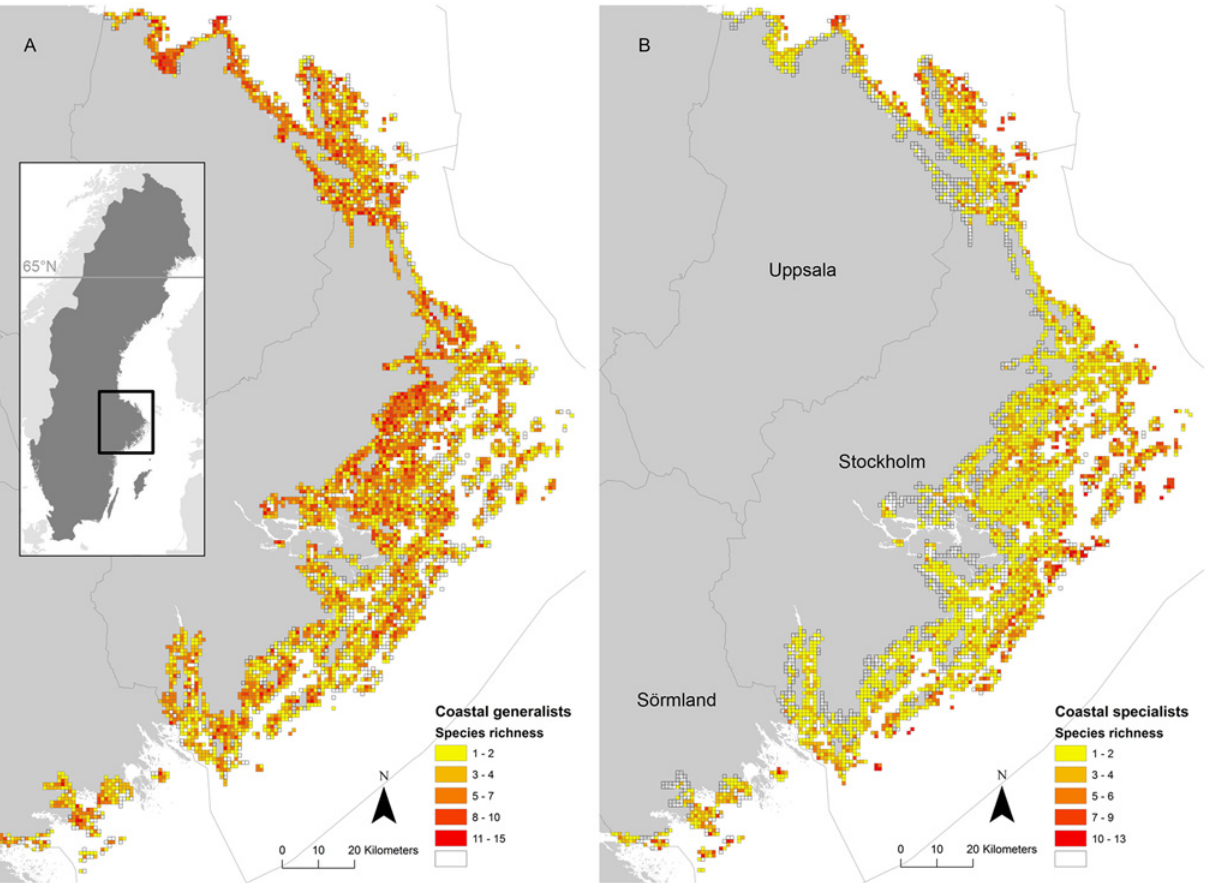
Fig 1. Species richness patterns of coastal specialist and generalist species. The archipelago is situated in the Baltic Sea off the east coast of Sweden. Observed number of species per square for (A) generalist species and (B) specialist species. The location of the counties are shown in